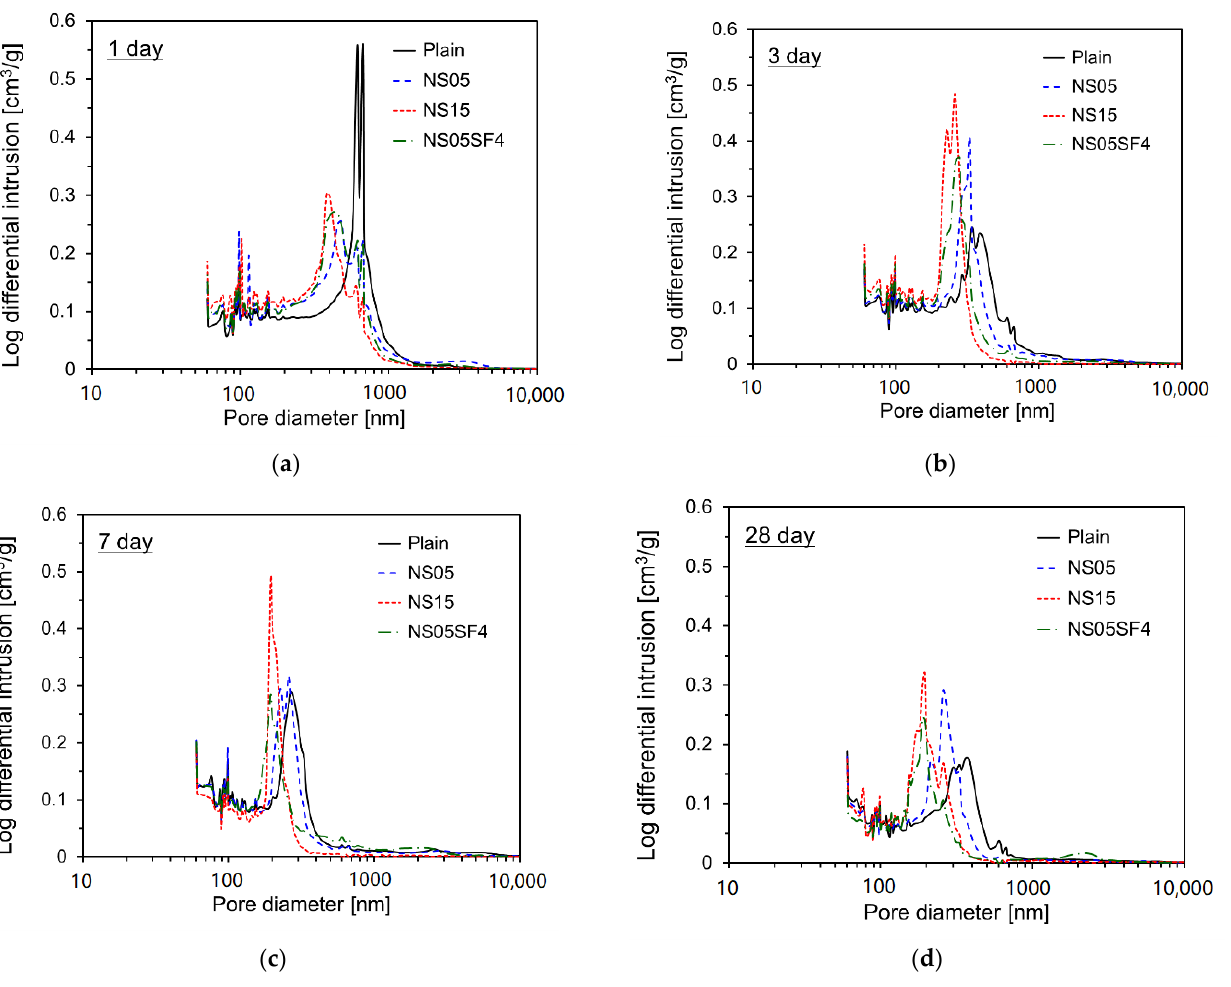
Figure 10. Log differential intrusions for specimens by pore diameter. ( a ) 1 day; ( b ) 3 days; ( c ) 7 days; ( d ) 28 days.